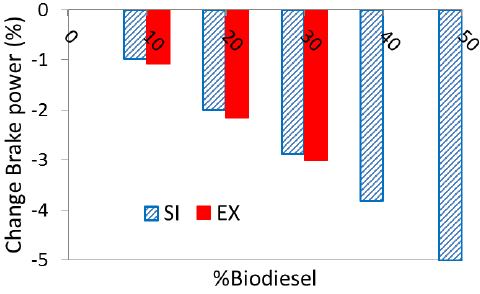
Figure 8. Relationship between capacity and biodiesel blending ratio of simulation (SI) and experiment (EX).